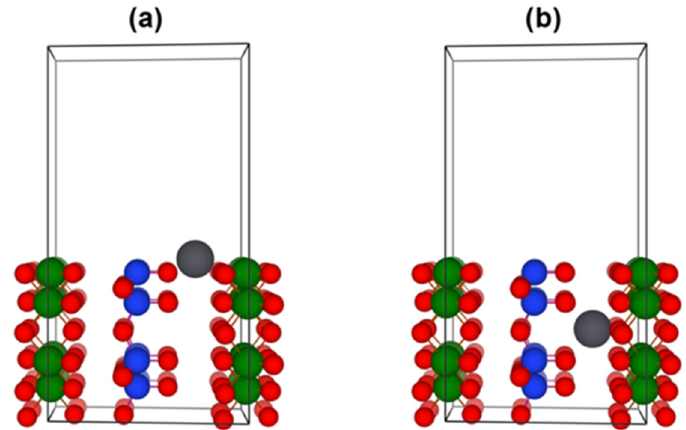
Figure 6. ( a ) Initial and ( b ) final state geometries used in the CI-NEB simulation of heavy metal ion interlayer migration in the halloysite (7 Å).